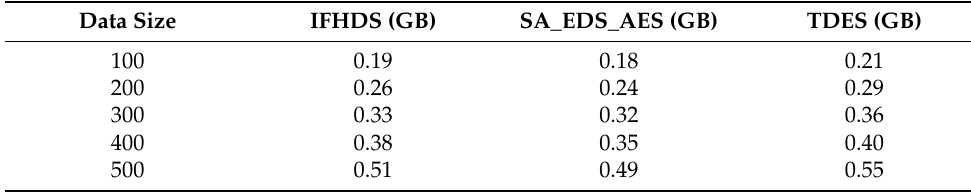
Figure 5. TDES network usage is compared with existing techniques.